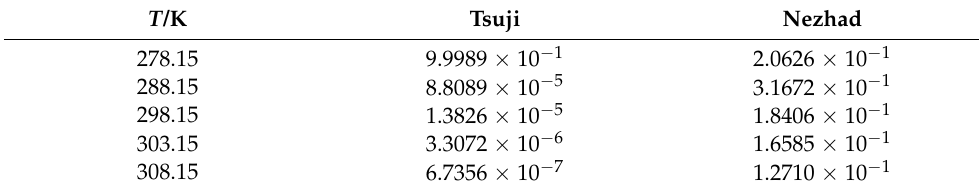
Table 12. Calculation results of ω i value of 7-ADCA correlation solubility and pH model.